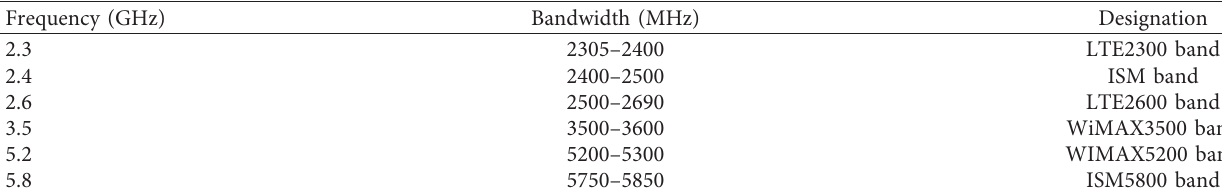
Figure 2: Smartwatch for IoT enabling. Table 1: Frequency specification of the antenna design